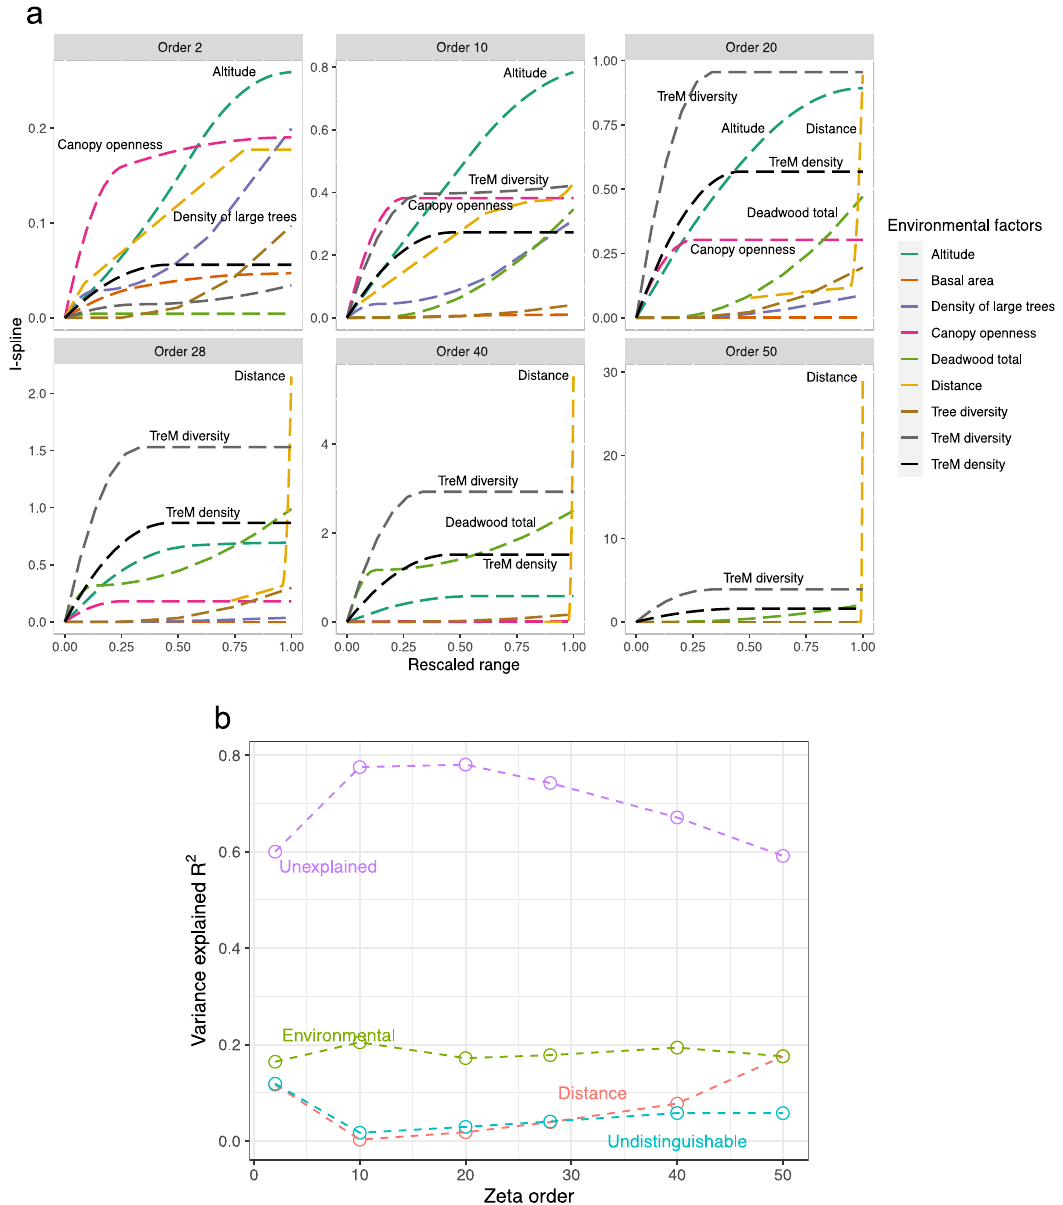
Fig. 9 Environmental variables driving species community changes (zeta diversity changes). a I-splines mean values of predictors from 30-rounds calculation with Sørensen-equivalent metric for seven environmental variables with their respective contributions to zeta diversity. Environmental contributions are shown for six different zeta orders (i.e. ζ i ) here referring to plots compared together (from ζ 2 to ζ 50), with the main contributively environmental variables highlighted for each zeta order. We observed a shift in the key forest features explaining community changes according to geographic scale, with canopy openness and altitude as main environmental drivers at local scale ( ζ 2), replaced by tree-related microhabitats diversity and deadwood amount at large scales (from ζ 28 to ζ 50). b Proportion (in r 2 ) of the total zeta-diversity variance explained by environmental variables, distance, undistinguishable variables or unexplained, according to zeta order. The eight tested environmental variables accounted for 15 – 20% or the total variance in community changes regardless of zeta order, with distance explaining up to 20% of the total variance as well depending on the different zeta orders